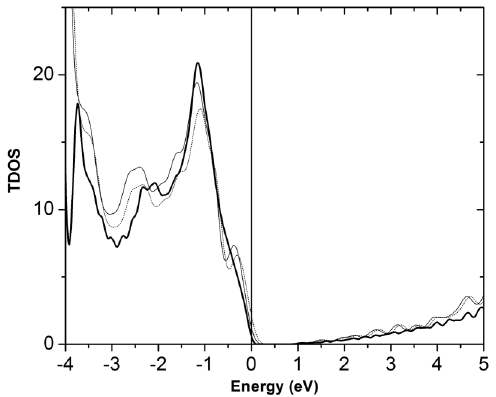
FIG. 6. Total density of states of bulk (bold line) and GZO crystal of nearly 6% (thin solid line) and 3% Ga concentration (thin dashed